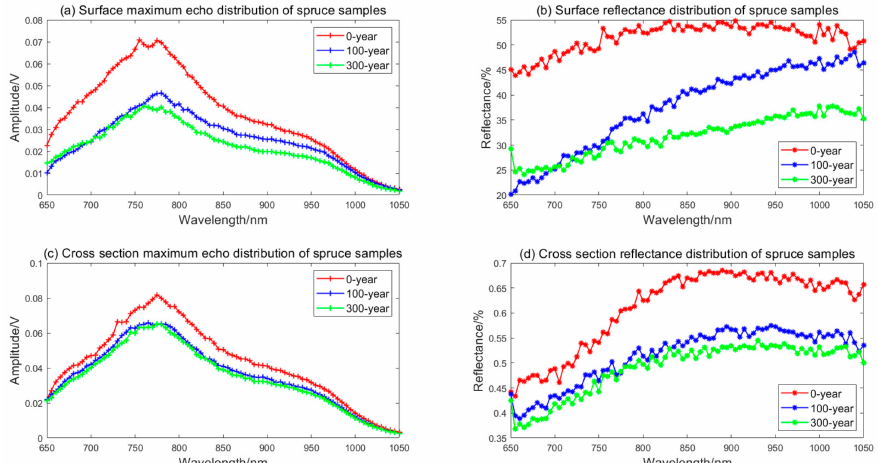
Figure 7. The comparison of spruce samples surface and cross-section echo and reflectance. ( a ) Surface maximum echo distribution of spruce samples. ( b ) Surface reflectance distribution of spruce samples. ( c ) Cross section maximum echo distribution of spruce samples. ( d ) Cross section reflectance distribution of spruce